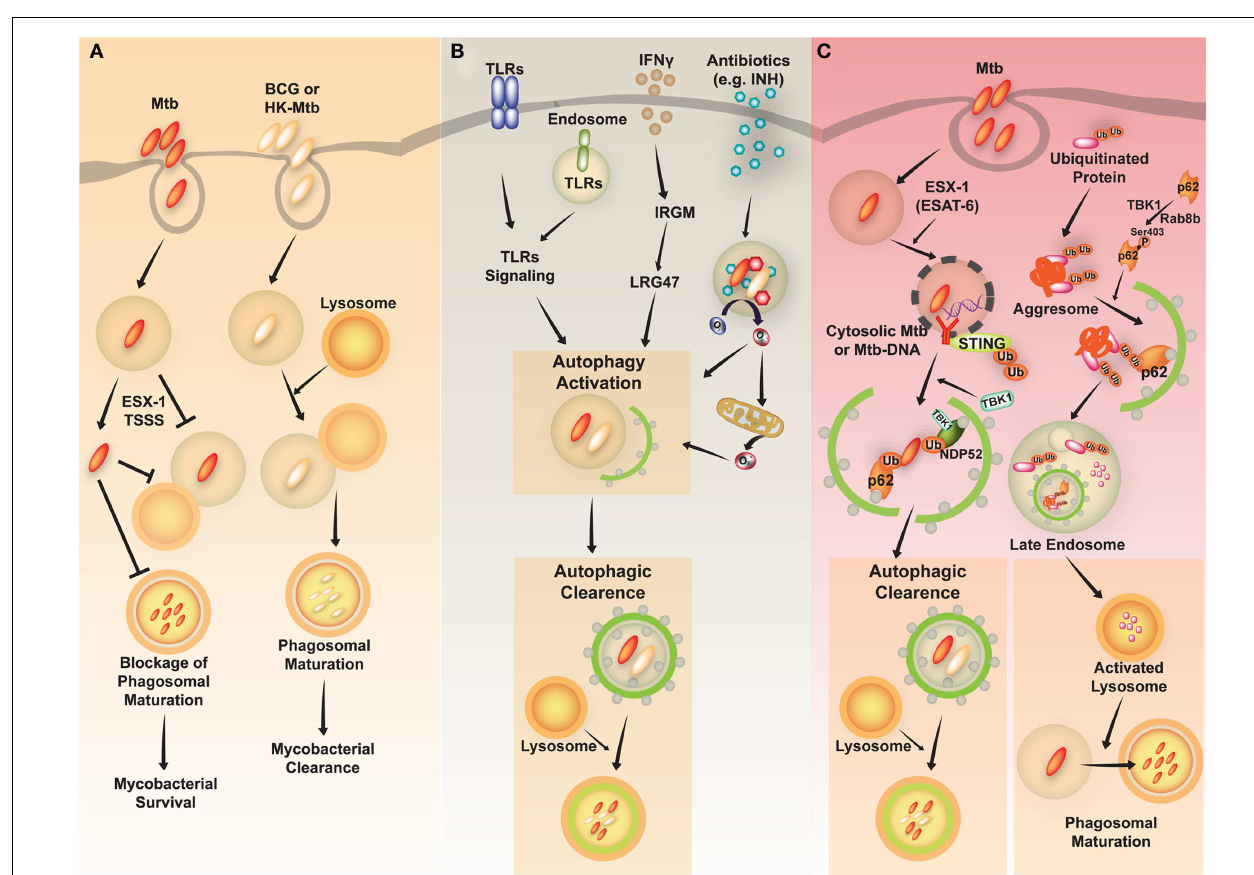
which then results in autophagic clearance of Mtb. Antimycobacterial antibiotics activate autophagy, which depends on cellular and